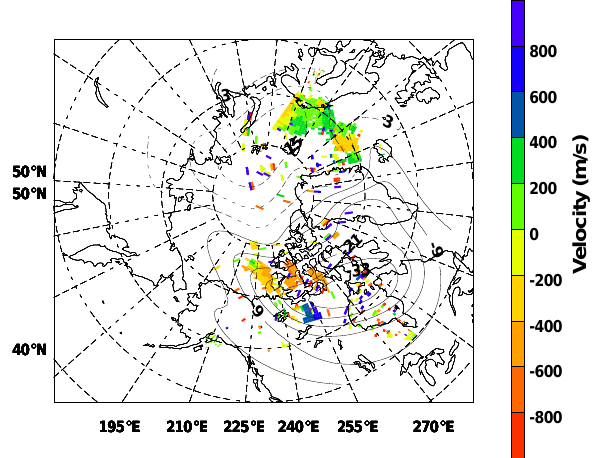
Fig. 3. Color-coded line-of-sight velocity data (blue for flow to- wards, red for flow away) from the 8 operating Northern Hemi- sphere SuperDARN radars for the time interval 23:30–23:31UT. This information is used to calculate ionospheric equipotential flow streamlines by using the technique of Ruohoniemi and Baker (1998) which are presented as contour lines. Actual data coverage includes the region where the Cluster magnetic footpoints are located. the cusp where it encounters downward precipitating magne- tosheath ions. The position of SC4 and the ion open-closed field line boundary is marked with a white triangle on SC4’s red magnetic foot point line. SC1, slightly delayed in space and time to SC4, was still on closed field lines as was SC3. Based on the center and form of the SuperDARN convection cell and the known location of the ion open-closed field line position of the ion open-closed field line boundary is indi- cated with a black dashed line. Note that the location of the ion open-closed field line boundary is based on the arrival of downward precipitating ions at Cluster. These ions need